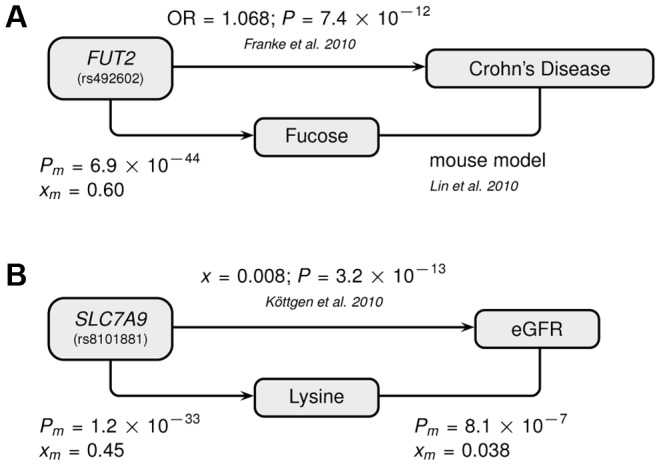
Genotype-Metabotype-Phenotype associations.The two novel gene-metabolite associations of this study implicate SNPs that had previously been associated with disease-related phenotypes by the indicated publications: (A) Fucose–Crohn's disease–FUT2 (rs492602), (B) Lysine–eGFR–SLC7A9 (rs8101881). A link between the metabolite and the phenotype has been established for (A) based on a mouse model and for (B) by a direct correlation with the indicated significance and effect size. Abbreviations: OR refers to the odds ratio, x to the linear regression effect size, P to the corresponding P-value, and the m-index indicates values obtained in the combined CoLaus and TasteSensomics sample.